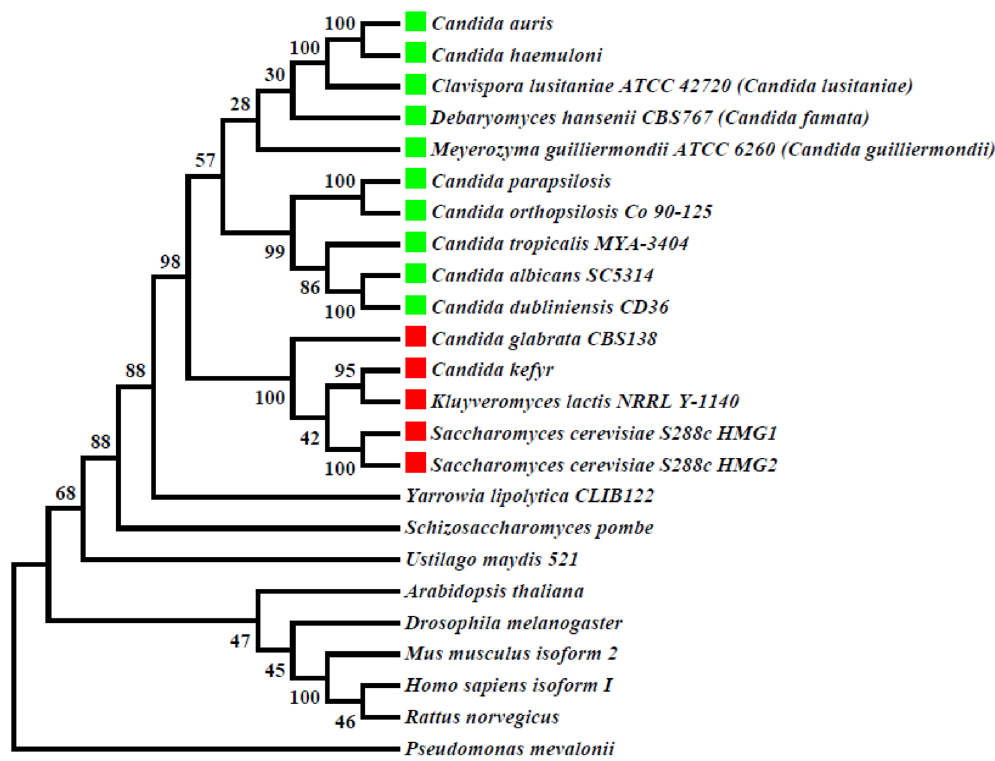
Figure 2. The phylogenetic tree of the catalytic domain of HMGR enzymes in different organisms. The percentage of replicated trees in which the associated taxa are grouped in the 100 bootstrap replicates is shown next to the branches. The phylogenetic tree is drawn to scale, with the length of the branches representing the corresponding evolutionary distances according to the MEGA6 program, the maximum likelihood method, and the WAG + G model. The development of the species in the clade that encompasses Candida glabrata (in red) was based on whole genome duplication (WGD). In the clade containing Candida albicans (in green), the species developed based on genetic code transition